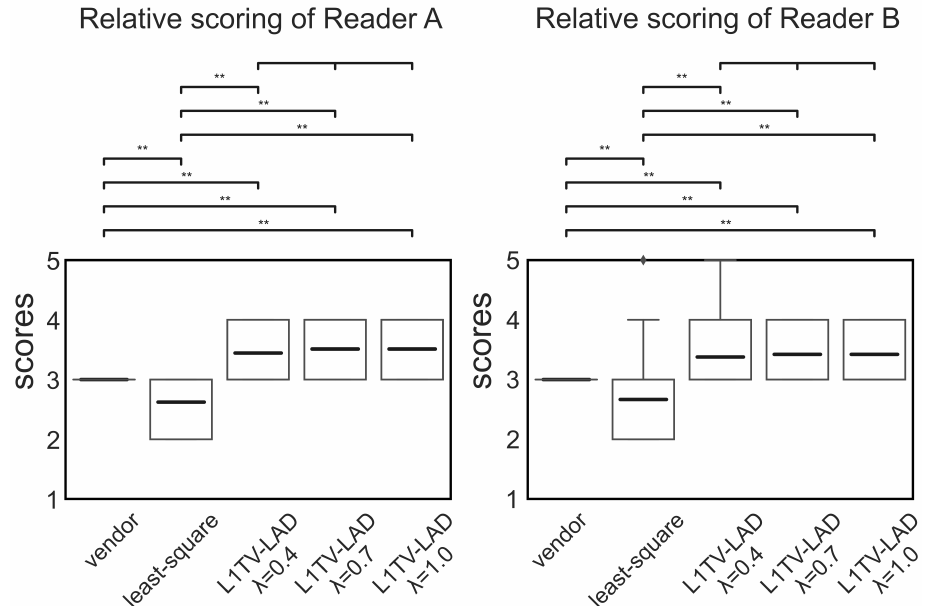
Figure 8. Boxplots of the relative scores by two readers. box: the first and the third quantile, bold lines: mean, whisker: maximum and minimum (may overlap with the box in most cases). Medians are overlapped by the box. (cid:7) : outliers. ** p <